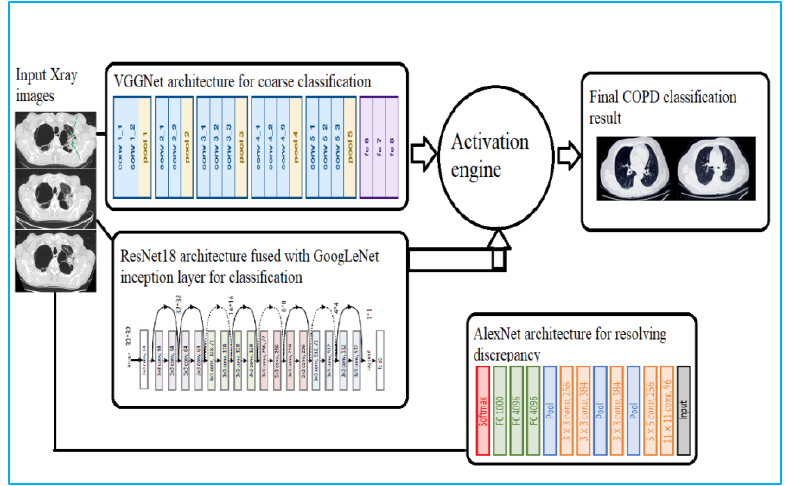
Figure 6. Proposed architecture for effective COPD classification using fused CNN.